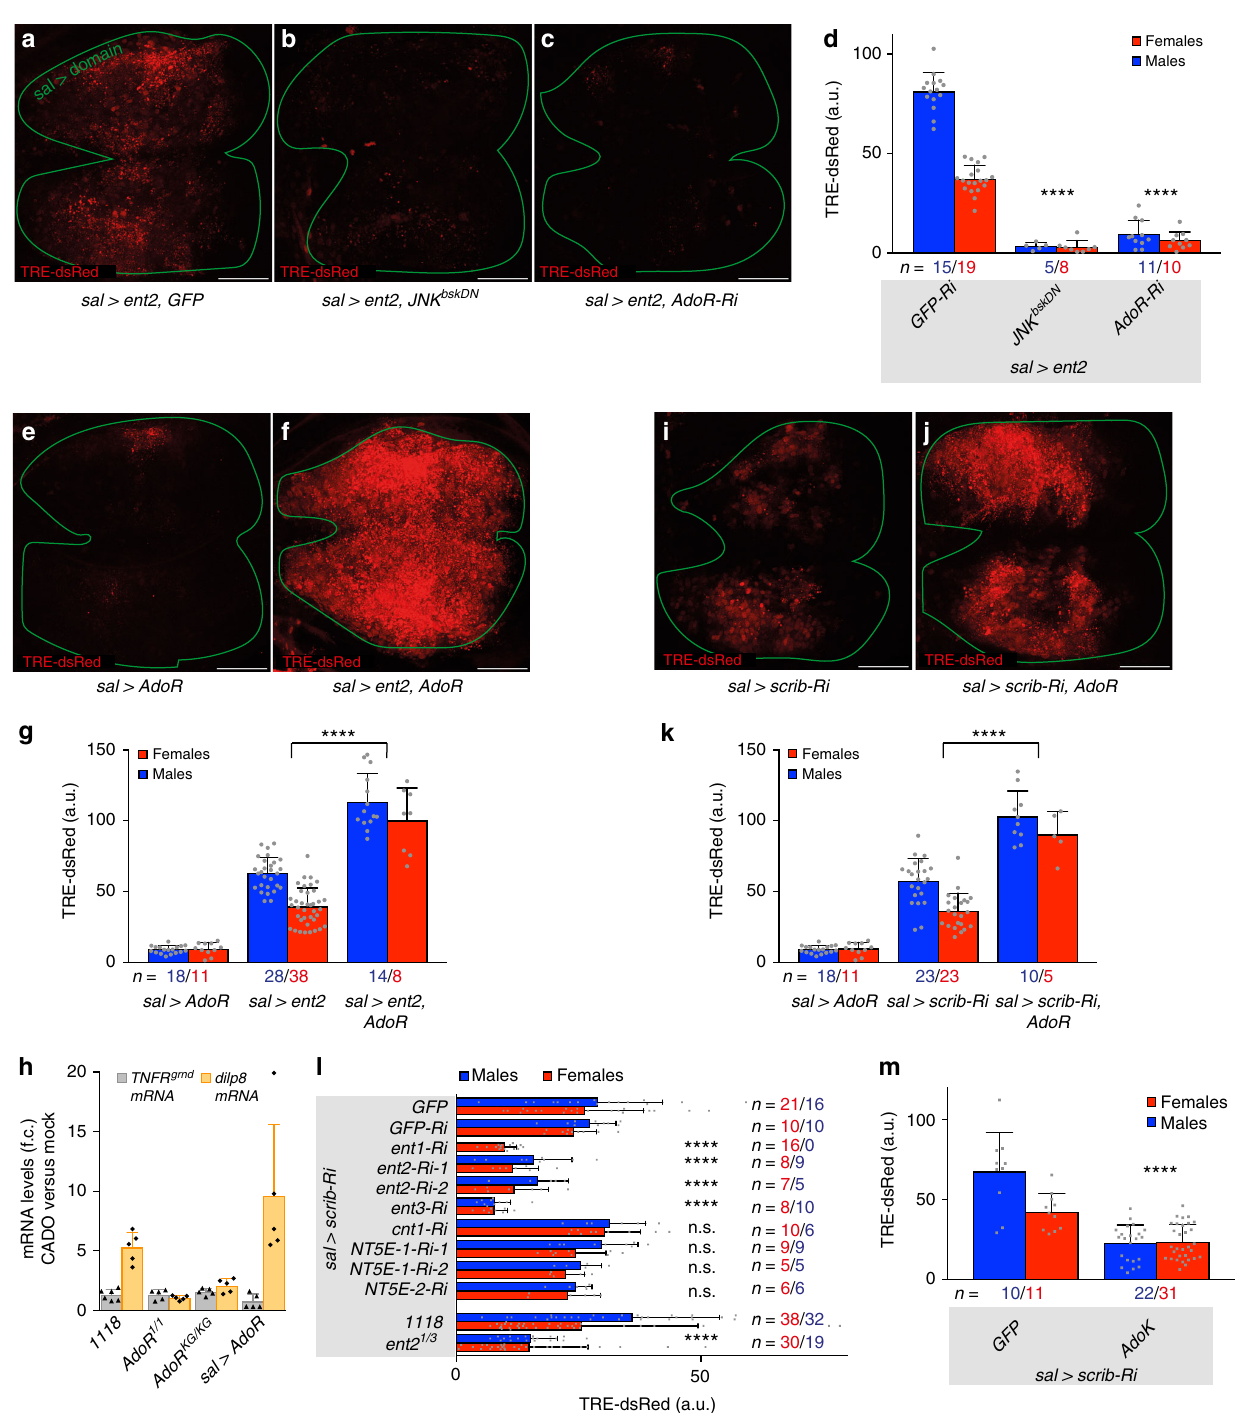
Fig. 2 AdoR is activated by adenosine released from polarity-de fi cient epithelial cells. a – d Ent2 overexpression ( sal > ent2 ) activates TRE-dsRed in the wing disc. This is suppressed by expression of JNK bskDN or silencing of AdoR . e – g AdoR overexpression ( sal > AdoR ) causes a very mild activation of TRE-dsRed on its own, but strongly enhances JNK activation caused by overexpression of Ent2. h CADO treatment increases expression of the JNK target gene dilp8 in explanted wild-type, but not in AdoR mutant discs. This effect is further enhanced by AdoR overexpression. Here, TNFR grnd expression, measured by RT- qPCR, is shown as a control. Fold changes are relative to rp49 , n ≥ 5. i – k AdoR overexpression leads to a strong enhancement of scrib -RNAi mediated activation of JNK signalling. l , m Silencing of various equilibrative adenosine transporter genes ( ent1 , ent2 , ent3 ) by RNAi, reduction of Ent2 activity in a hypomorphic background, ent2 1/3 ( l ) or overexpression of AdoK ( m ) suppress scrib -RNAi mediated activation of JNK, whereas silencing of concentrative adenosine transporter ( cnt1) , ecto-nucleotidase NT5E-1 or NT5E-2 had no effect ( l ). Experimental RNAi lines in ( l ) were compared to ‘ GFP-Ri ’ for statistical analysis. Scale bars, 50 μ m. In graphs, means are shown, and error bars represent ±SD; **** P < 0.0001, n.s. P ≥ 0.05, unpaired two-tailed Student ’ s t -test (males and females pooled